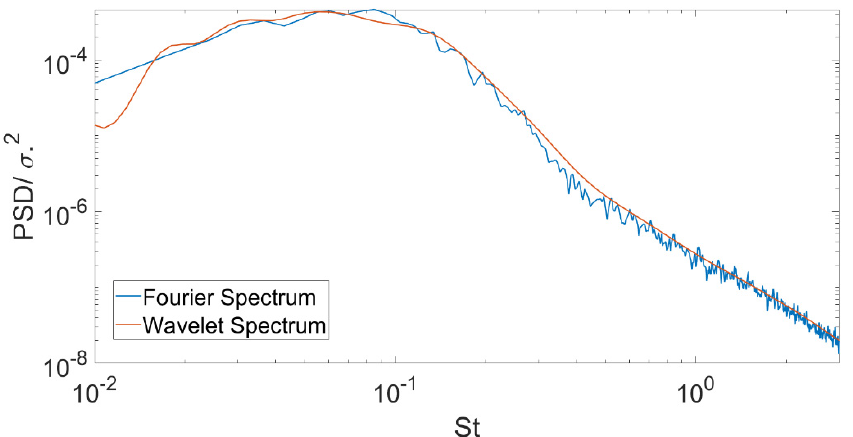
Figure 2. Power spectral density obtained from the Fourier decomposition (blue line) and from the wavelet scalogram (red line). Data refer to the same condition of Figure 1.